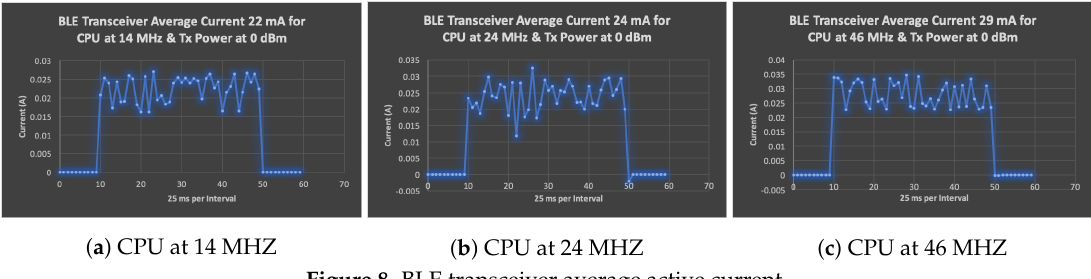
Figure 8. BLE transceiver average active